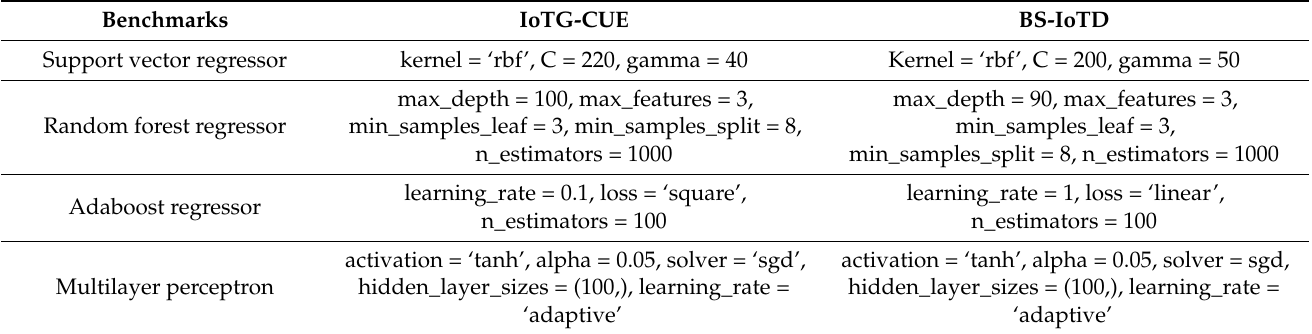
Table 5. Optimal parameters generated for the benchmarks used in the downlink model evaluation.